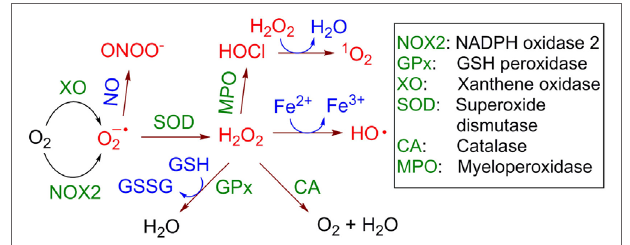
FigURe 2 | Generation and transformation of reactive oxygen species in live cells. Reactive species are red